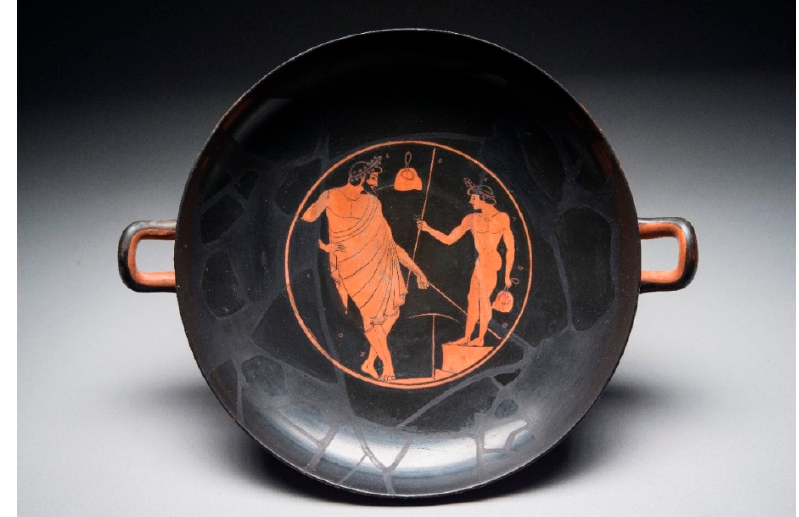
Figure 6. Kylix attributed to the Kiss Painter. Baltimore, Johns Hopkins Archaeological Museum B5. Photo courtesy the Johns Hopkins Archaeological Museum. Used by permission. 500 BCE.